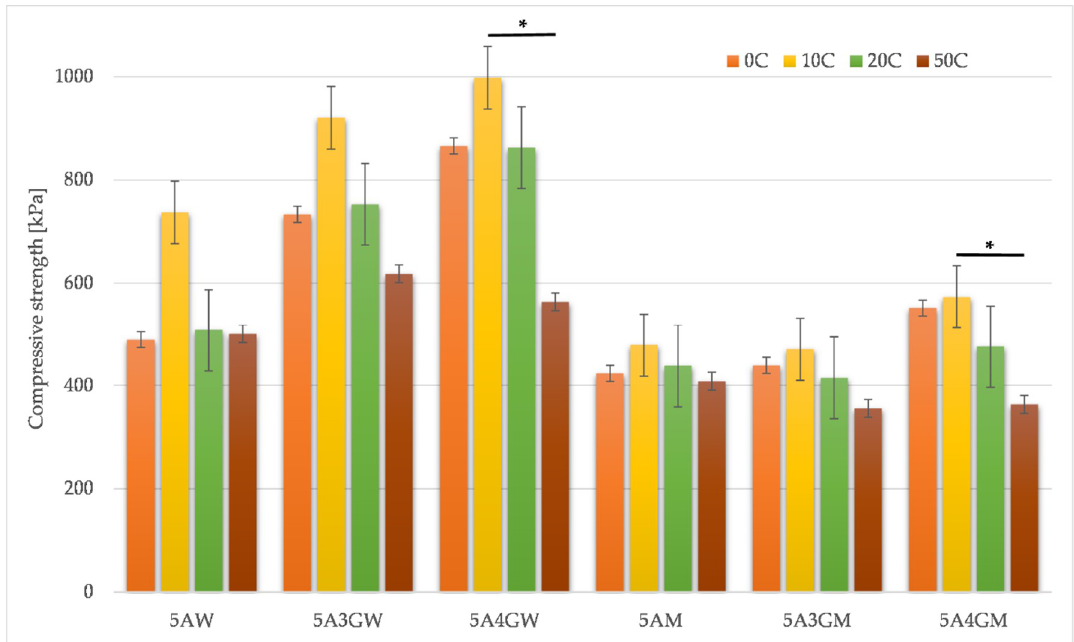
Figure 5. Compressive strength results for samples dissolved in water (W) and full culture medium (M) with different content of gelatine after 0 (0 C, reference samples), 10 (10 C), 20 (20 C), and 50 (50 C) cycles of loading and unloading (* = p < 0.05, results statistically significant).